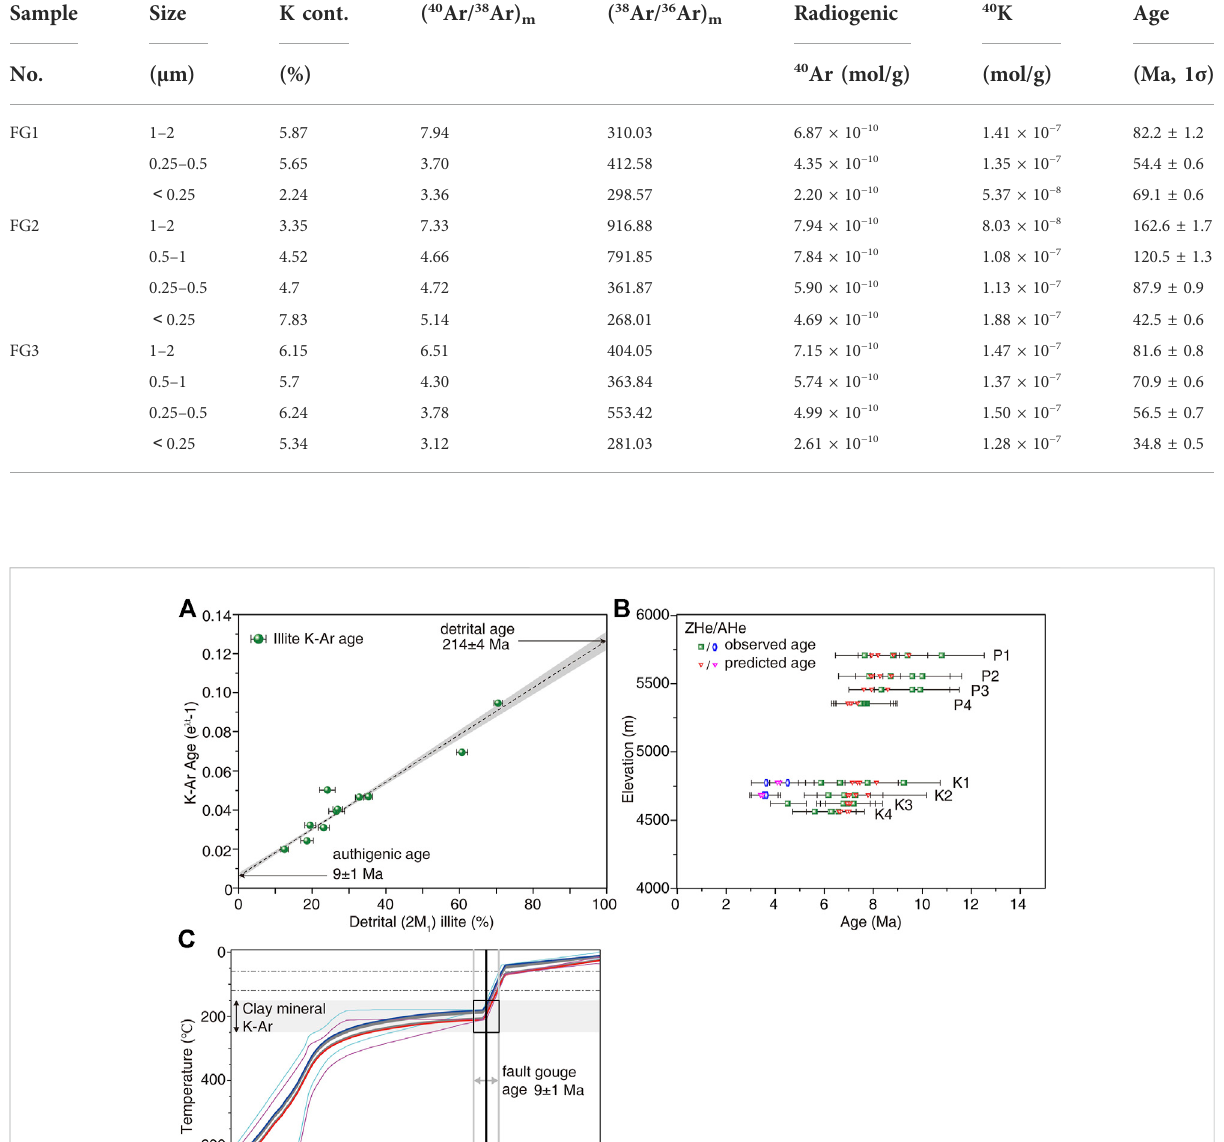
TABLE 2 K – Ar ages for the different size fractions of illite isolated from the fault gouge samples. Sample Size